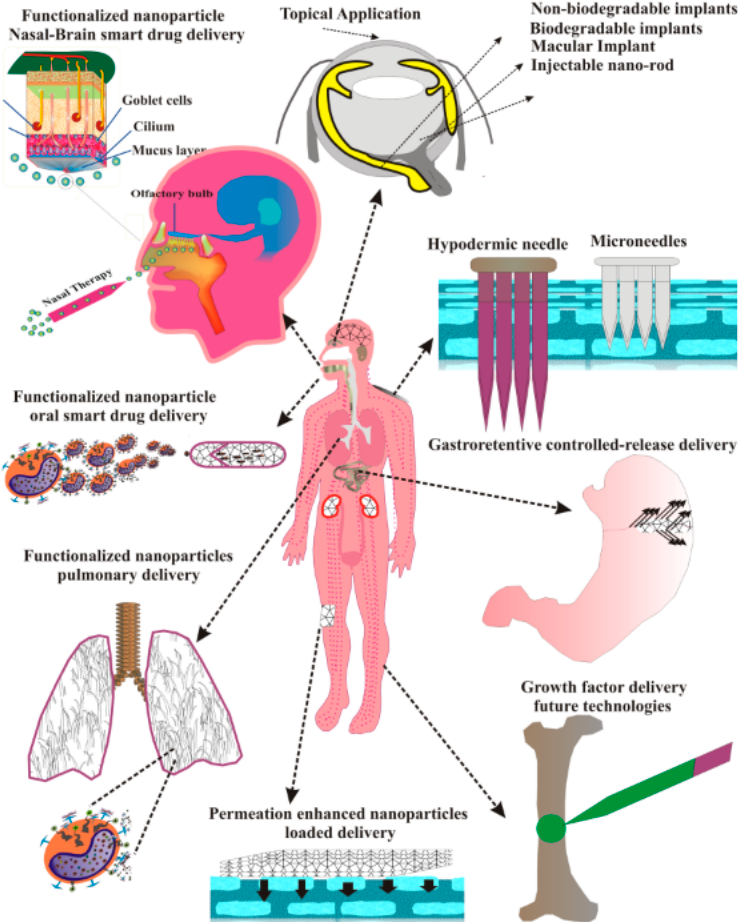
Figure 11. Schematic illustration of non-invasive or minimally invasive routes of administration and targeting strategies for polymeric nanoparticles. From Reference [191], open access peer-reviewed edited volume, Copyright (2014) IntechOpen.